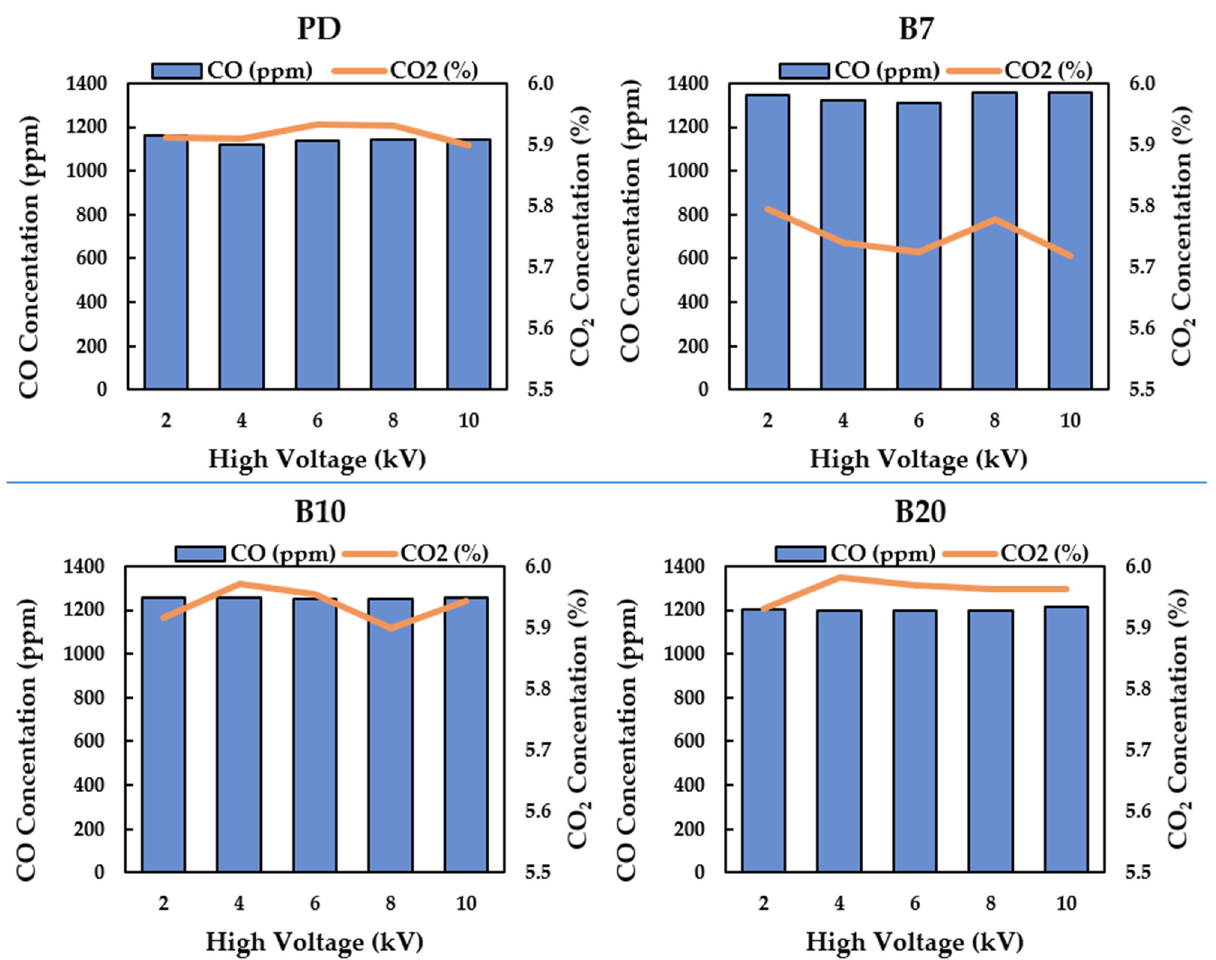
Figure 3. Effect of NTP on CO and CO 2 concentrations at an engine speed of 2000 rpm and IMEP 6 bar.